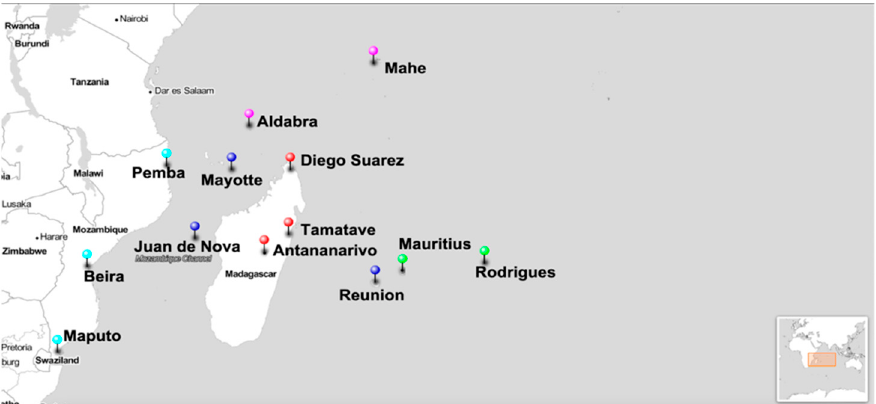
Figure 1. Map of the south-west Indian Ocean (SWIO) tropical cyclone basin (30–90° E, 0–40° S). The principal locations discussed in the paper are indicated by dark blue (France), light blue (Mozam- bique), green (Mauritius), red (Madagascar), and pink (Seychelles) circles.